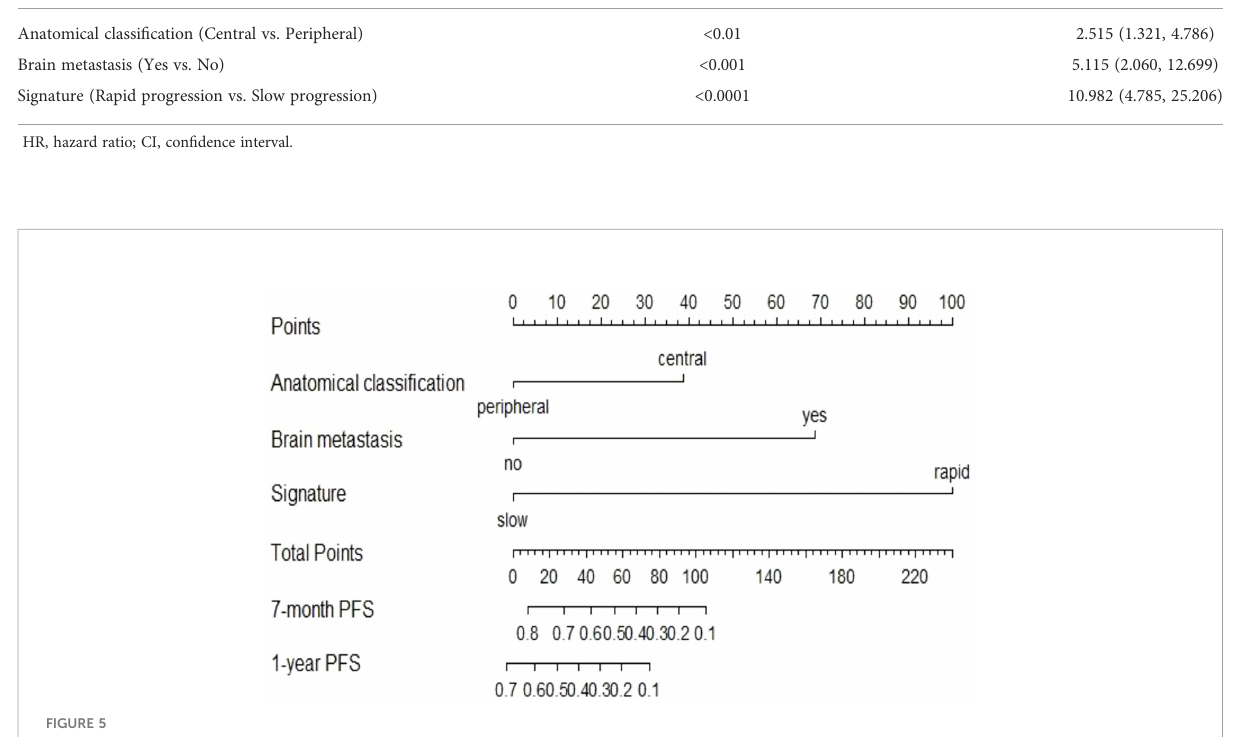
FIGURE 5 Nomogram to predict the 7-month and one-year PFS probabilities of NSCLC patients after ICI treatment.